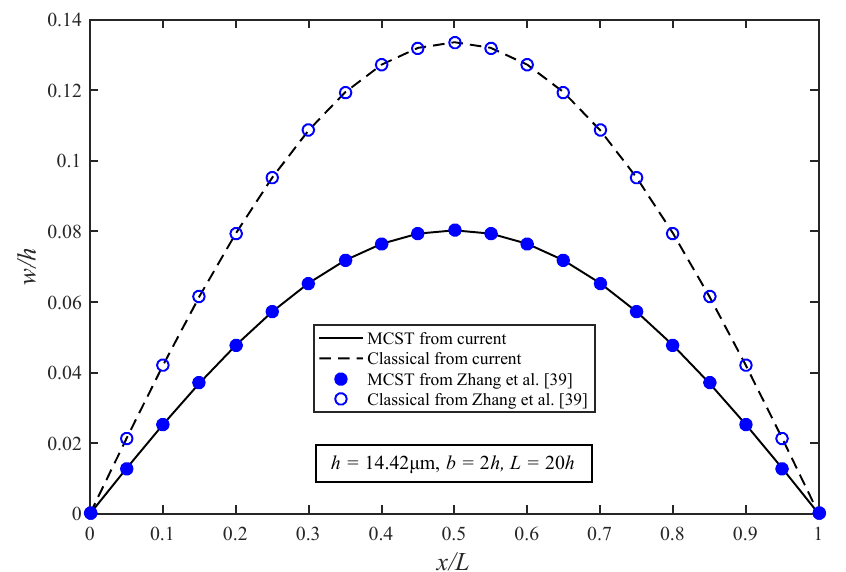
Figure 2. Comparison of the deflection of the simply supported microbeam subjected to a uniform load.